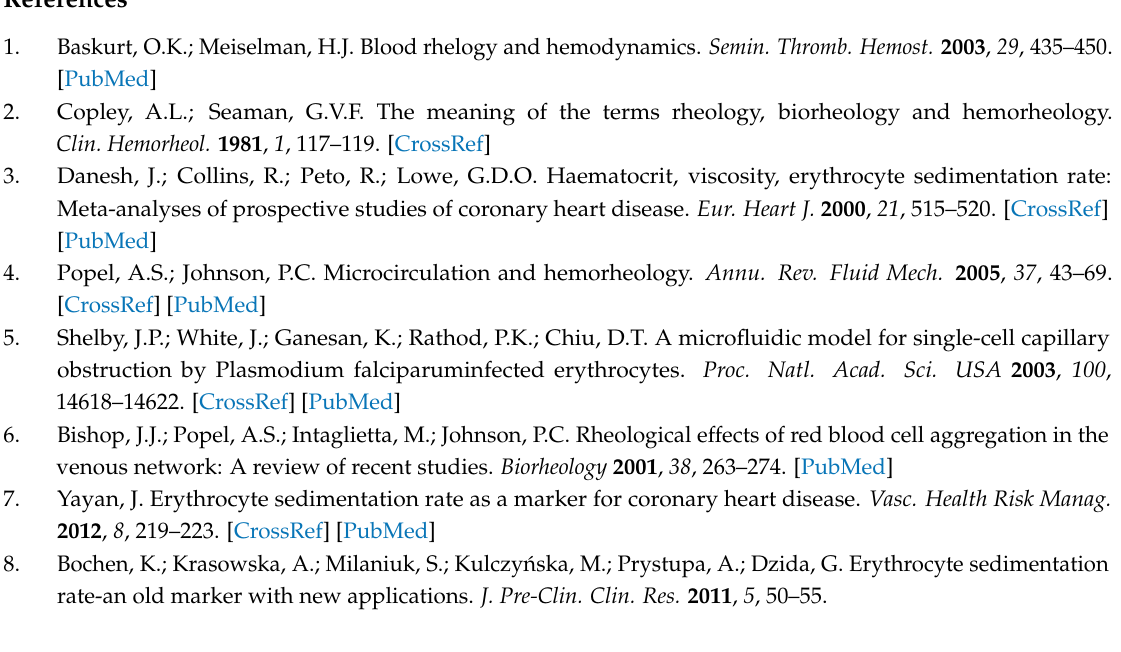
as RBC deformability, RBC aggregation, and hematocrit. Figure S1: Specific dimensions of the microfluidic device used for the simultaneous measurement of multiple biophysical